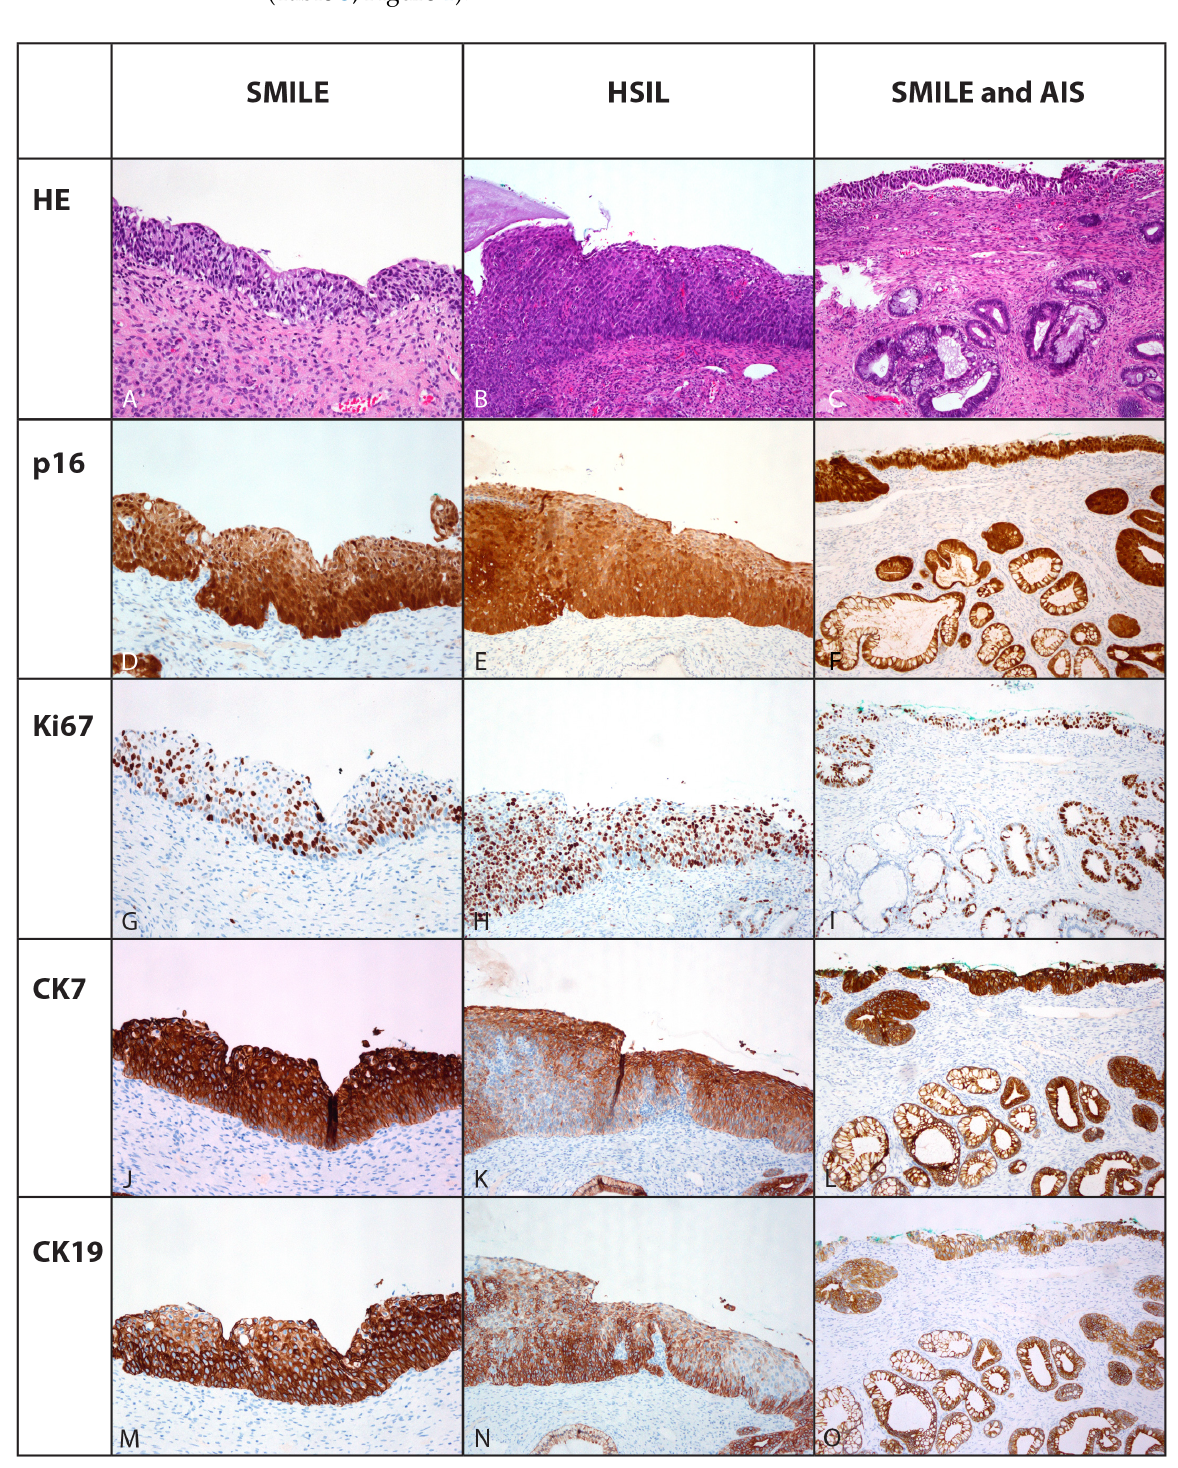
Figure 1. Immunohistochemical expression of p16, Ki67, CK7 and CK19 in stratified mucin-producing intraepithelial lesion involving the surface epithelium ( A , D , G , J , M ), in high-grade intraepithelial squamous lesion, focally underlaying endocevical epithelium ( B , E , H , K , N ) and endocervical adenocarcinoma in situ in the endocervical crypts with remnants of SMILE in the surface epithelium ( C , F , I , L , O